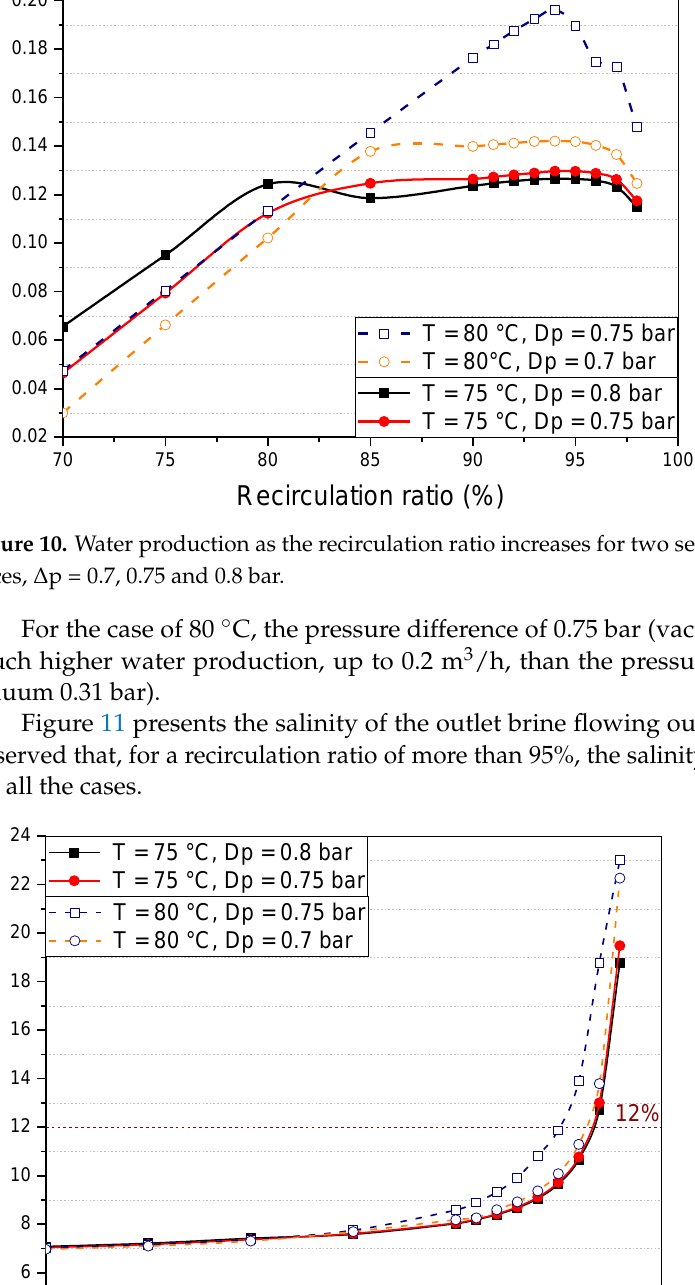
T = 75 °C T = 80 °C T = 85 °C Figure 9. Specific energy consumption as the recirculation ratio increases for the set-points of 75, 80, 85 °C. 3.2. Effect of Pressure Difference Derived by Vacuum Pump In the previous section, the effect of the heat pump set-point temperature on the